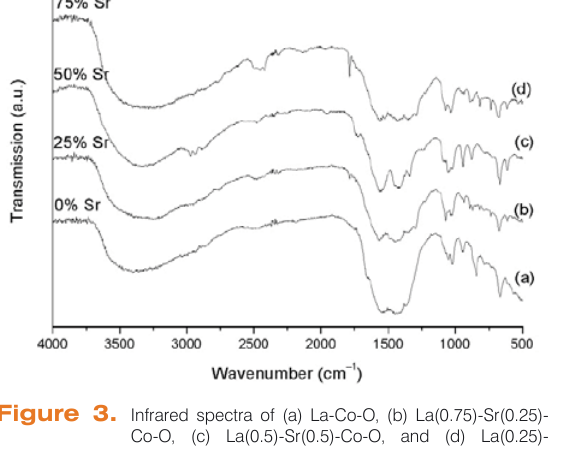
, (b) La Sr CoO , (c) 3 0.75 0.25 3- d